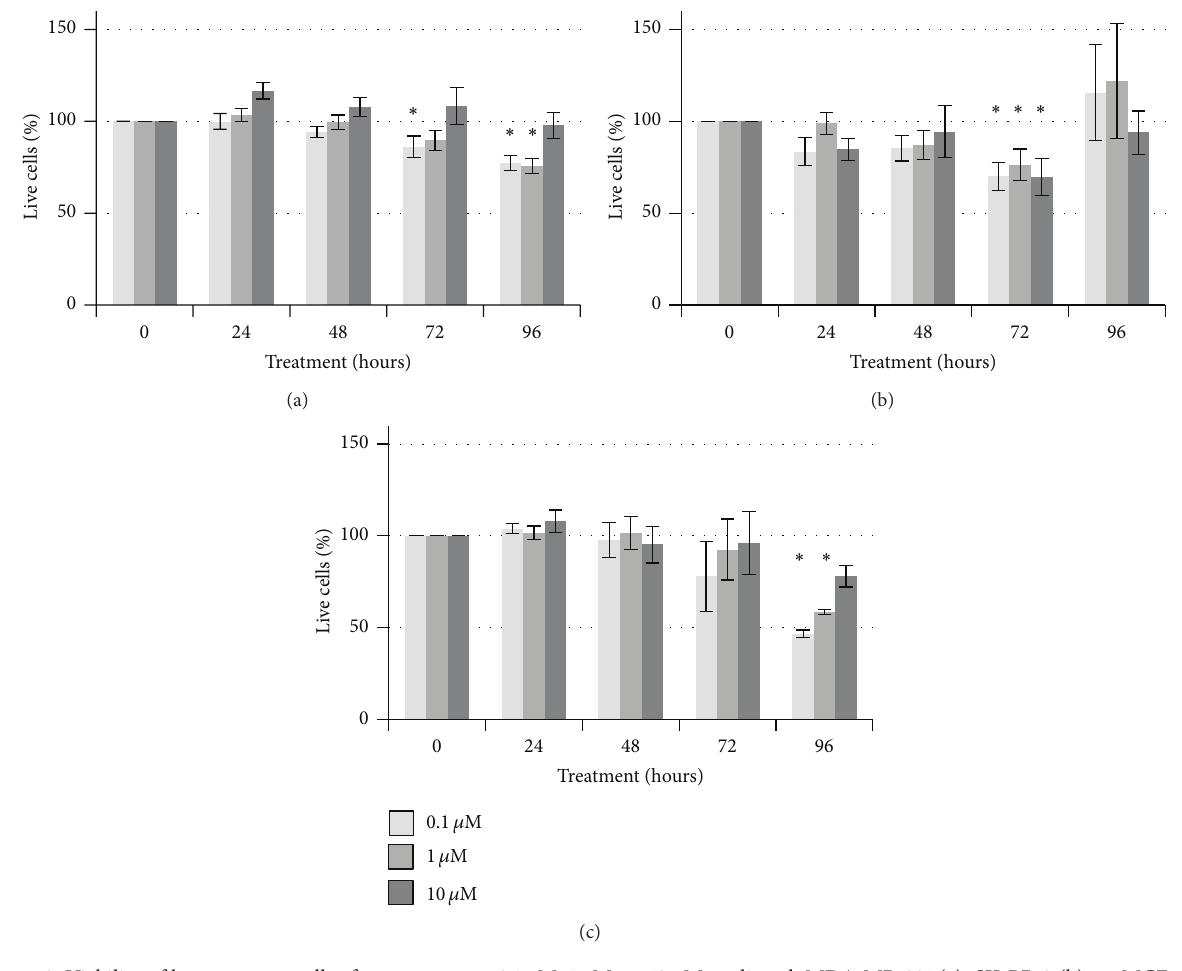
Figure 2: Viability of breast cancer cells after exposure to 0.1 𝜇 M, 1 𝜇 M, or 10 𝜇 M paclitaxel. MDA-MB-231 (a), SK-BR-3 (b), or MCF-7 (c) cells were treated for up to 96 hours with either paclitaxel or DMSO vehicle control. Significant differences compared to the vehicle control ( ∗ 𝑃 < 0.05 ) are